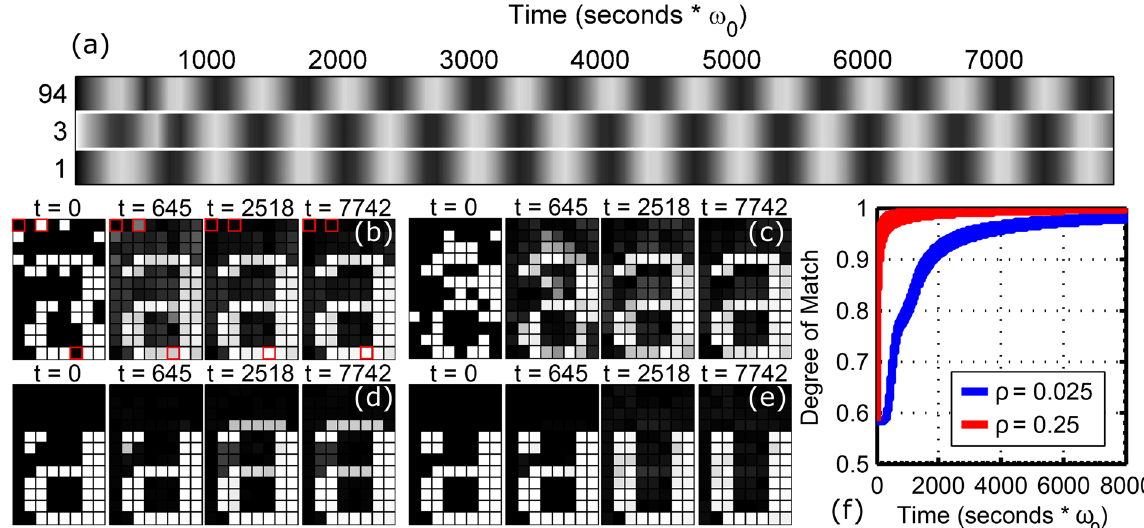
Figure 2. In the absence of distributed frequencies and nonlinearity, the system evolves predictably from the initial conditions, always selecting the stored pattern with the highest degree of match with the initial conditions. In figures ( b ) and ( c ), recognition of the “a” pattern is achieved even with significant distortion. Figure ( a ) shows the entire time series of the three highlighted pixels in ( b ). Pixels 1 and 97 start in phase but end out of phase. Pixels 1 and 3 start out of phase but end in phase. Figures ( d ) and ( e ) demonstrate the borderline case where recognition transitions from the stored “a” pattern to the stored “u” pattern. For similar patterns, significant distortion is not required before this transition occurs. Figure ( f ) demonstrates the effect of increasing the coupling strength ρ by an order of magnitude. The time needed to achieve a high degree of match is dramatically reduced.